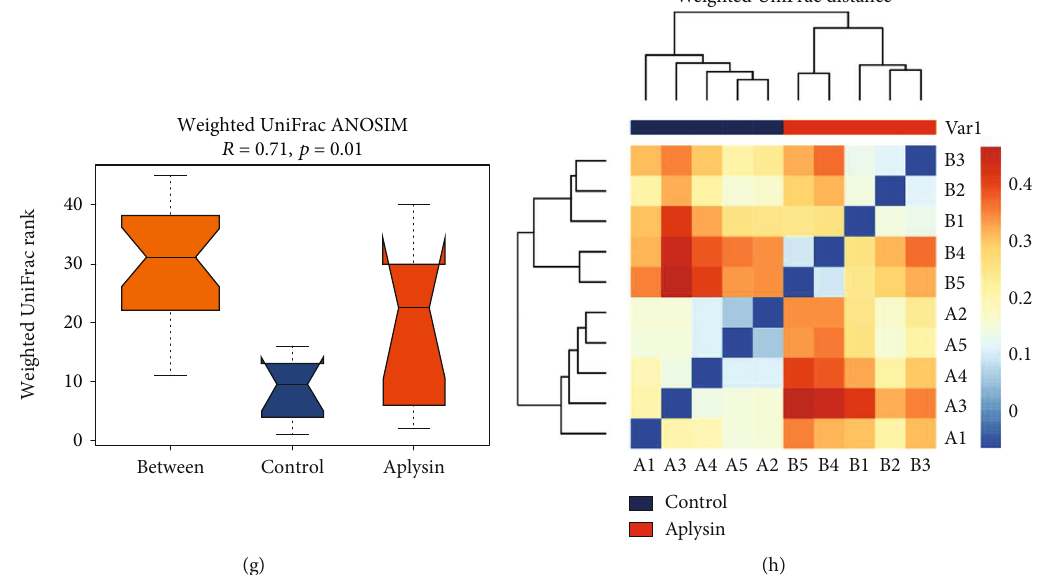
Figure 7: The diversity analysis of the intestinal fl ora of mice. (a) A Venn diagram showing the number of the common and unique bacterial OTUs between the control and aplysin intervention groups. (b) Species accumulation curves and (c) goods_coverage assessing sequencing depth. (d) The Chao1 showing species richness of the intestinal fl ora. p > 0 : 05 indicates that there was no obvious di ff erence between groups. (e) The Shannon index showing species evenness. p > 0 : 05 indicates that there was no obvious di ff erence between groups. (f) Principal coordinate analysis (PCoA) of intestinal fl ora among all samples. Cluster of samples implies their species compositions were similar or identical. p < 0 : 05 indicated that the di ff erence between the two groups for the corresponding principal coordinate was obvious. (g) ANOSIM (analysis of similarity). R > 0 and p < 0 : 05 indicated an obvious di ff erence between these two groups. (h) The heat map based on weighted UniFrac distances of the 10 samples. Proximity of samples indicated similar species